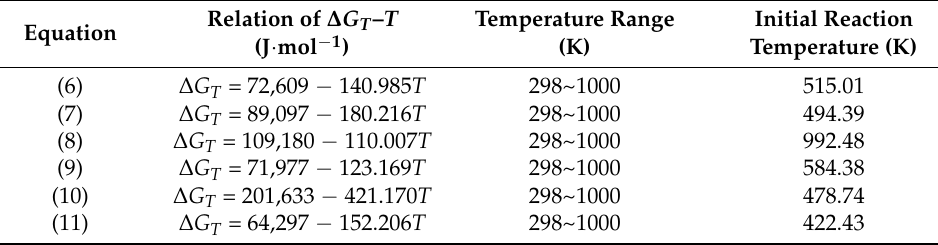
Figure 9. Reaction Δ G T –T diagrams in the system with the addition of NaOH. The XRD patterns of iron ore concentrates obtained at different NaOH dosages are shown in Figure 10. The main phases in the concentrate without NaOH are hematite, mag- netite, and quartz. With an increase in the NaOH dosage, the quartz peak disappears.